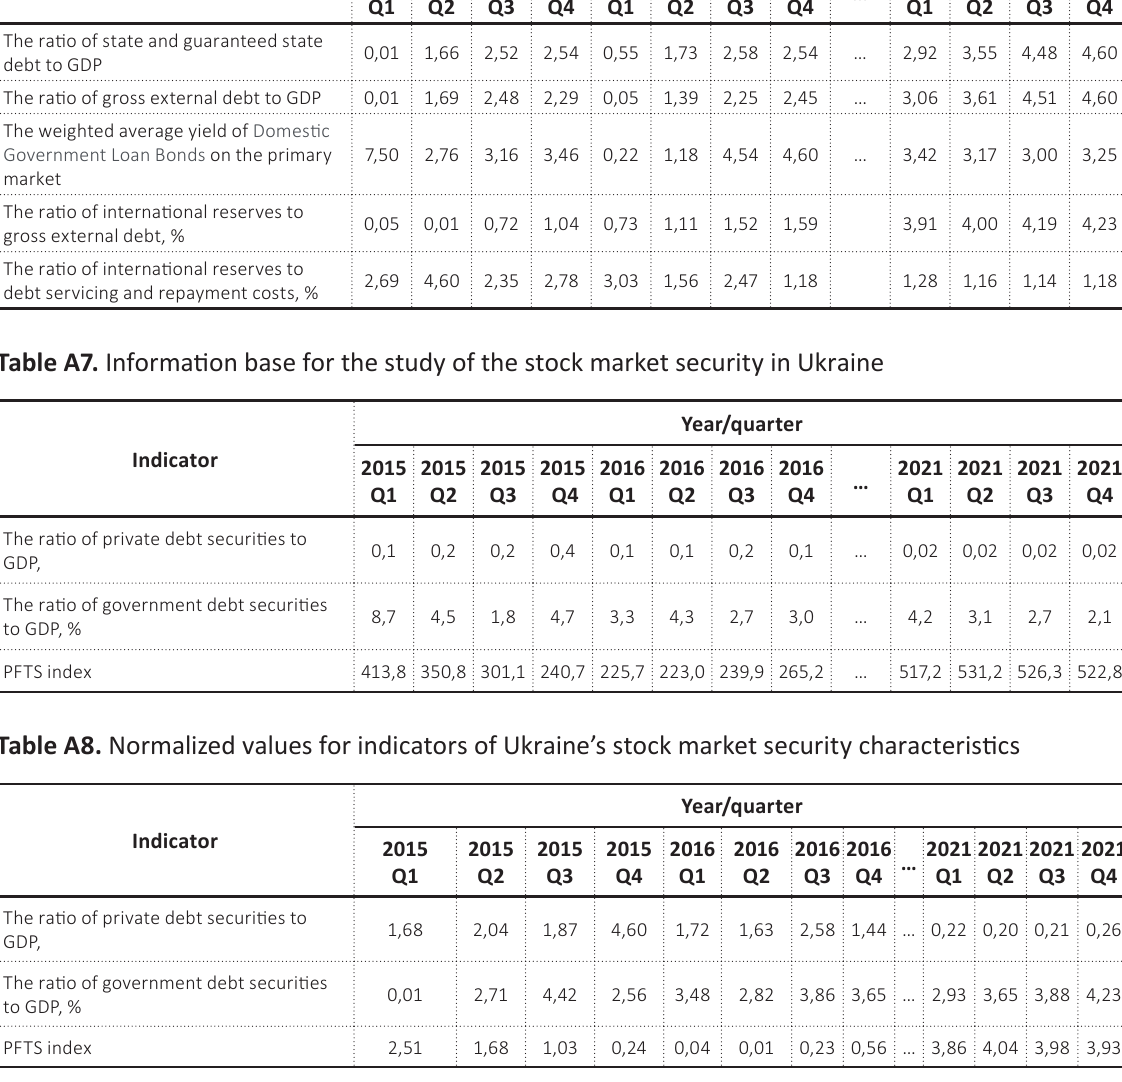
Table А6. Normalized values for indicators of Ukraine’s debt security characteristics Indicator